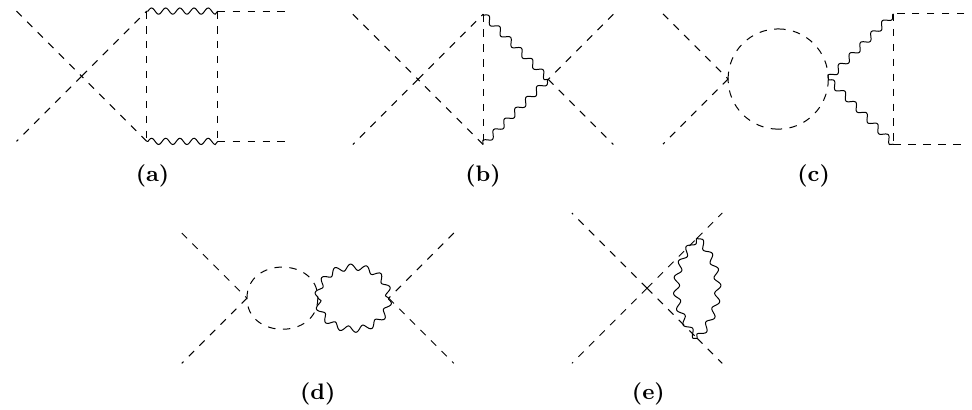
Figure 15. ( quartic · gauge 4 ) contributions to the two-loop beta function of quartic couplings.